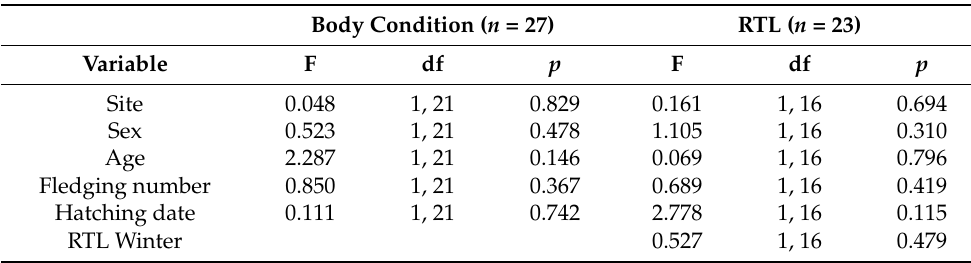
Table 2. Result of statistical analyses of morphological and genomic parameters changes between seasons for re-caught